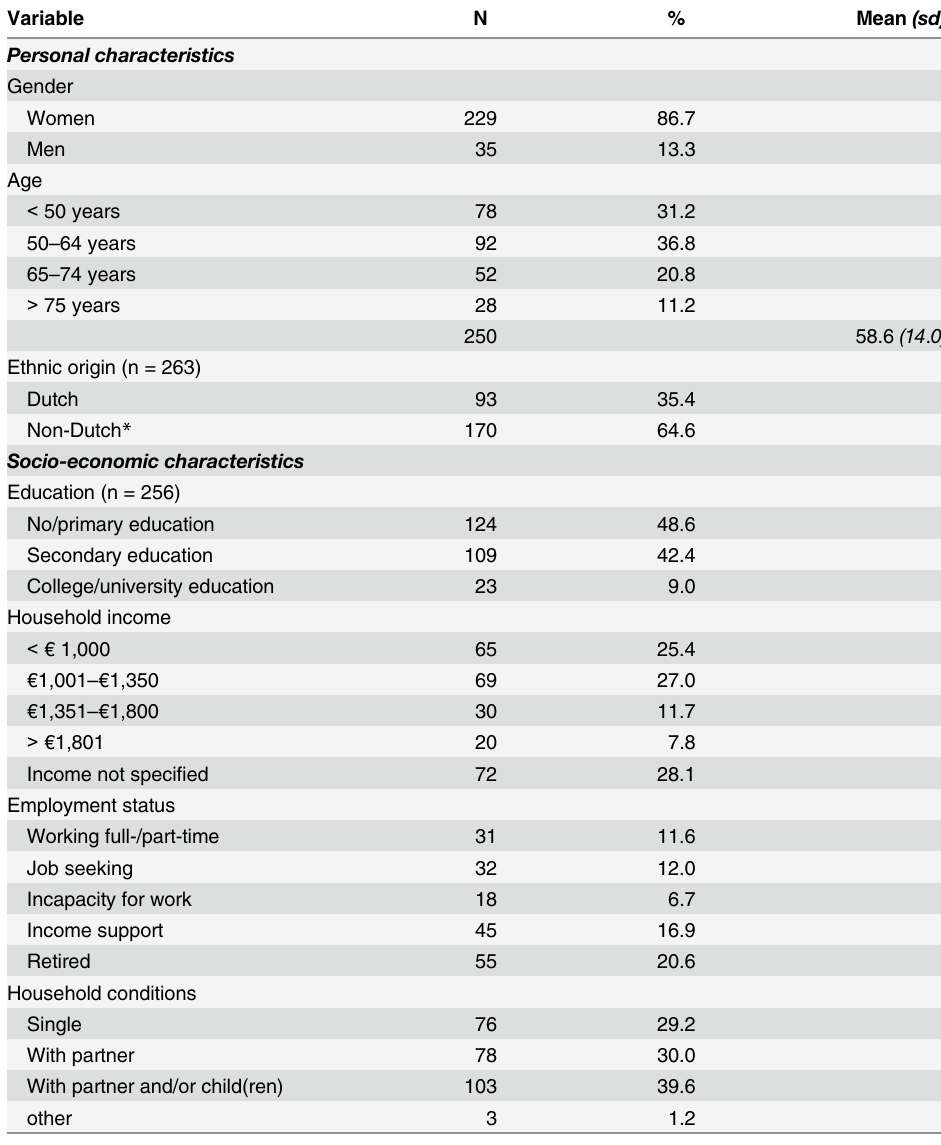
Table 2. Participants ’ personal and socio-economic characteristics (n =